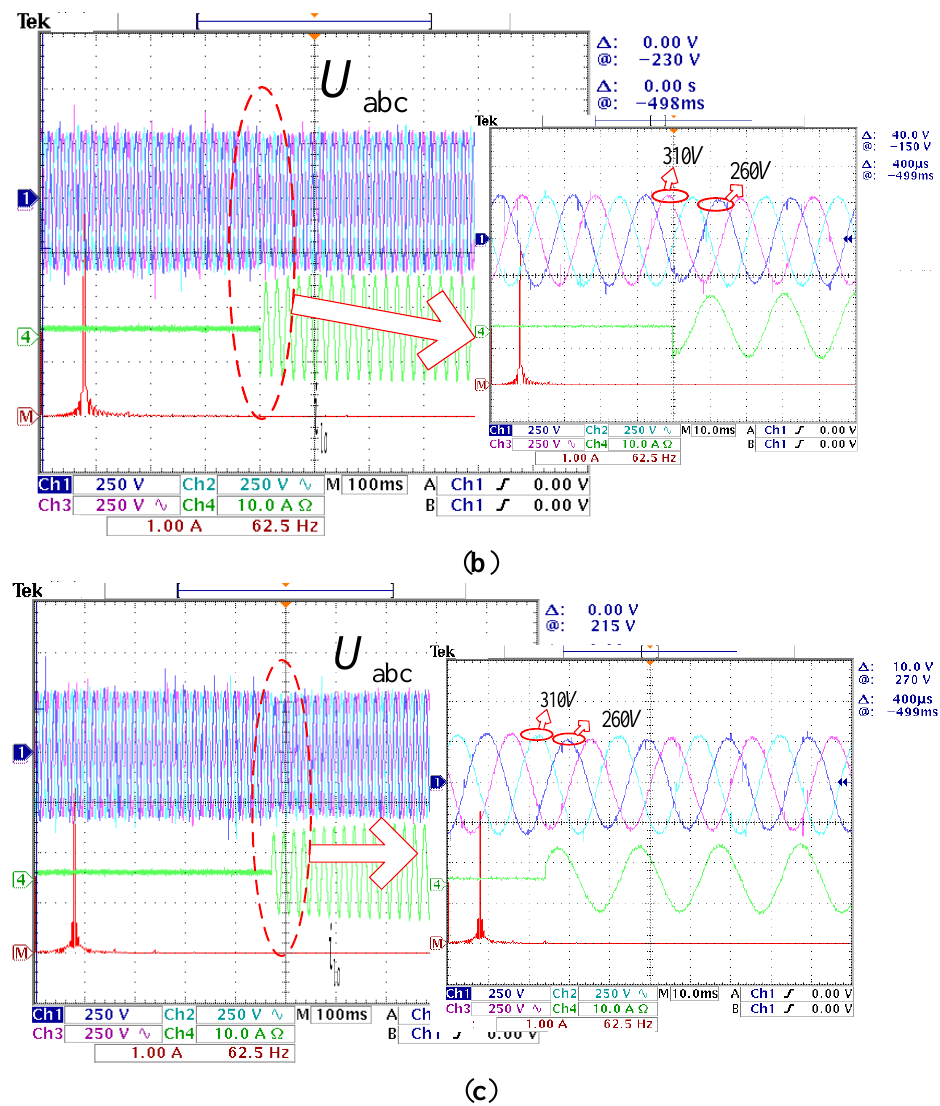
Figure 19. Experimental results under balanced load switch. ( a ) Proposed control scheme with LCO; ( b ) Proposed control scheme without LCO; ( c ) Traditional dual-loop control scheme.